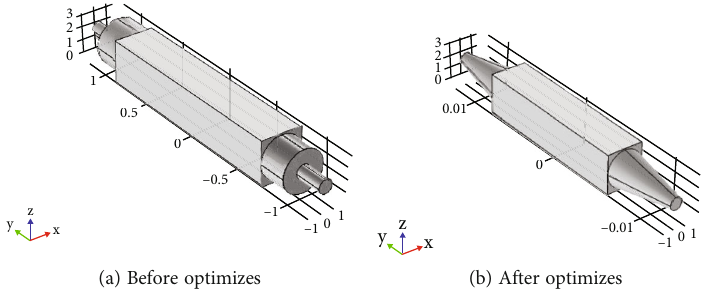
Figure 2: The whole gas path model.